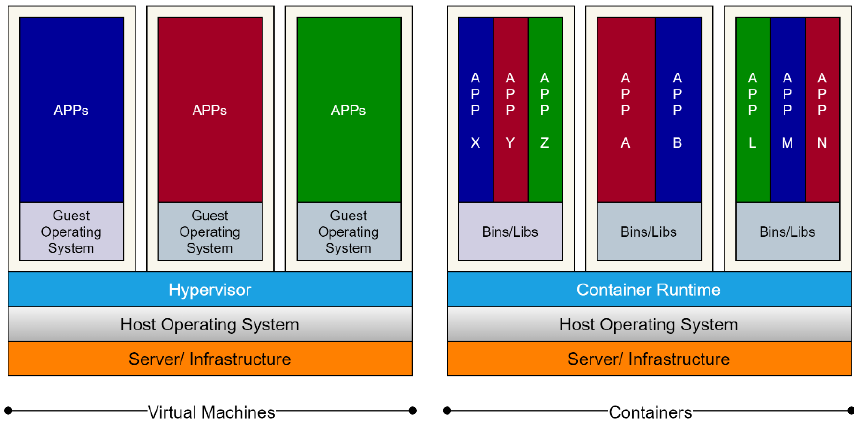
Figure 2. Difference between VM and containers.